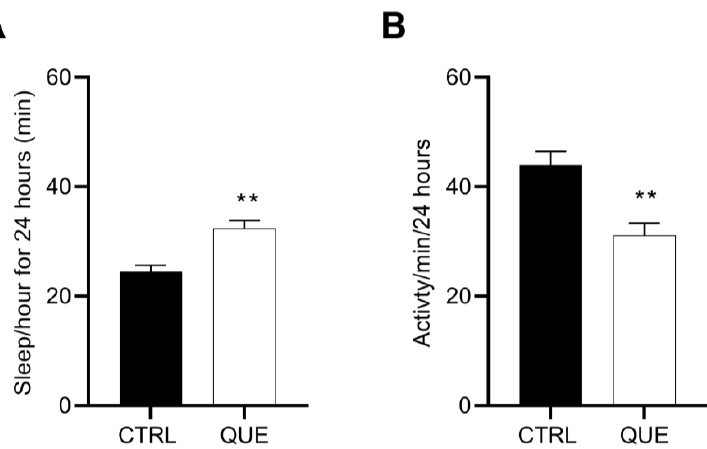
Figure A1. Diet supplemented with QUE increases sleep and reduces the activity in wt males. Wild type ( wt ) CantonS flies without treatment (CTRL) and orally fed for 24 h with 4.80 mM quercetin (QUE) were monitored for the amount of sleep and activity using DAM system at one minute resolution, at 25 °C, 70% humidity, and 12 h dark-light cycle. Results were presented as average ± standard error mean (SEM). ( A ) Total average sleep amount during 24 h ( n = 32). ( B ) Total average activity amount during 24 h ( n = 32). **: p < 0.01, unpaired Student’s t -test.